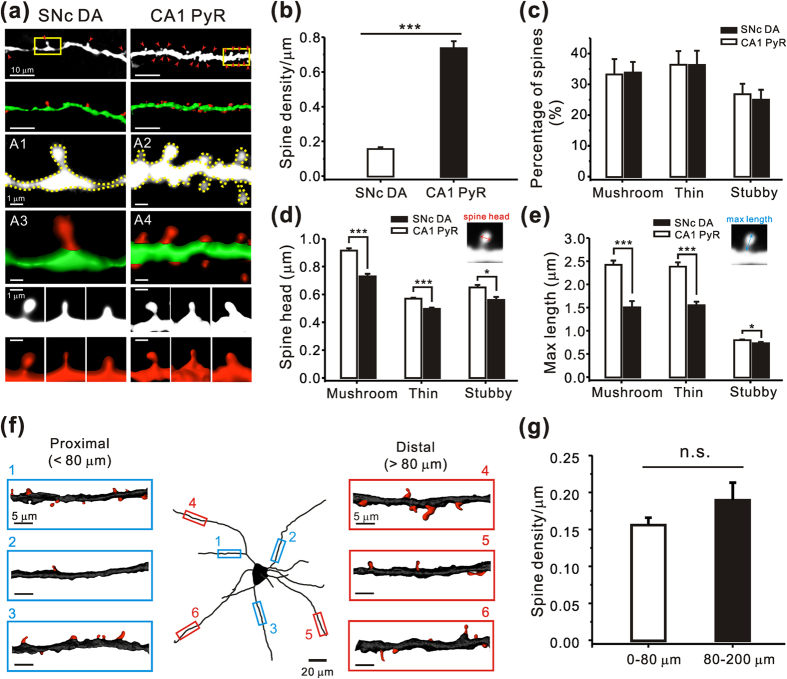
Morphological analysis of dendritic spines in the SNc dopamine neurons.(a) Monochrome and three-dimensional (3D) reconstructed images of the dendritic segment (green and red images; shafts are green and spines are red). Red arrowheads indicate dendritic spines. A1-4, monochrome and 3D-reconstructed images of the yellow boxed regions in the SNc dopamine neurons and CA1 pyramidal neurons, respectively, at high magnification. Lower panels show monochrome and 3D-reconstructed images of mushroom, thin, and stubby-type spines in SNc dopamine neurons and CA1 pyramidal neurons. (b) Mean spine densities of SNc dopamine neurons and CA1 pyramidal neurons (SNc, from 80 dendrites in 34 cells; CA1, from 23 dendrites in 5 cells). (c) Distribution of each spine subtype in SNc dopamine neurons and CA1 pyramidal neurons (SNc, mushroom = 189; thin = 174; stubby = 125; CA1, mushroom = 42; thin = 44; stubby = 31). (d,e) Comparison of mean spine head diameters and maximum longitudinal lengths in three typical subtypes of spines in SNc dopamine neurons (mushroom = 189; thin = 174; stubby = 125) and CA1 pyramidal neurons (mushroom = 42; thin = 44; stubby = 31). (f) Distribution of dendritic spines in SNc dopamine neurons. Each segment of dendritic regions (marked as blue [proximal] and red [distal] rectangles in the reconstructed projection image of a SNc neuron) is expanded in the blue and red boxed insets, in which dendritic shafts are seen with dendritic spines in red. (g) Average spine densities in the proximal (0–80 μm; n = 80) and distal (80–200 μm; n = 35) dendritic regions. * and *** represent p < 0.05 and p < 0.001, respectively, by unpaired t-test. Error bars represent SEM.